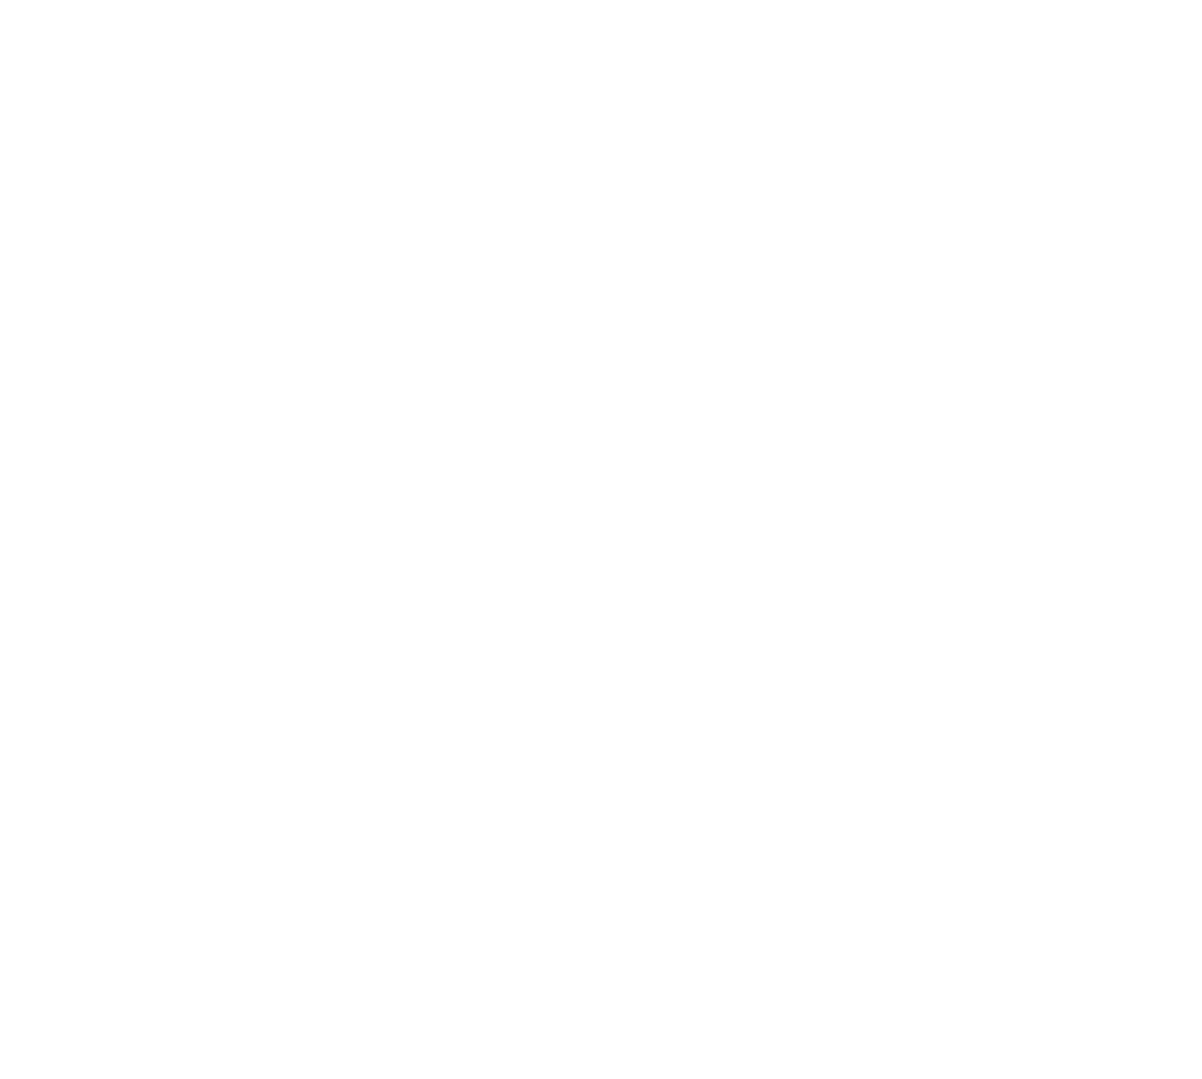
Frontiers in Astronomy and Space Sciences |